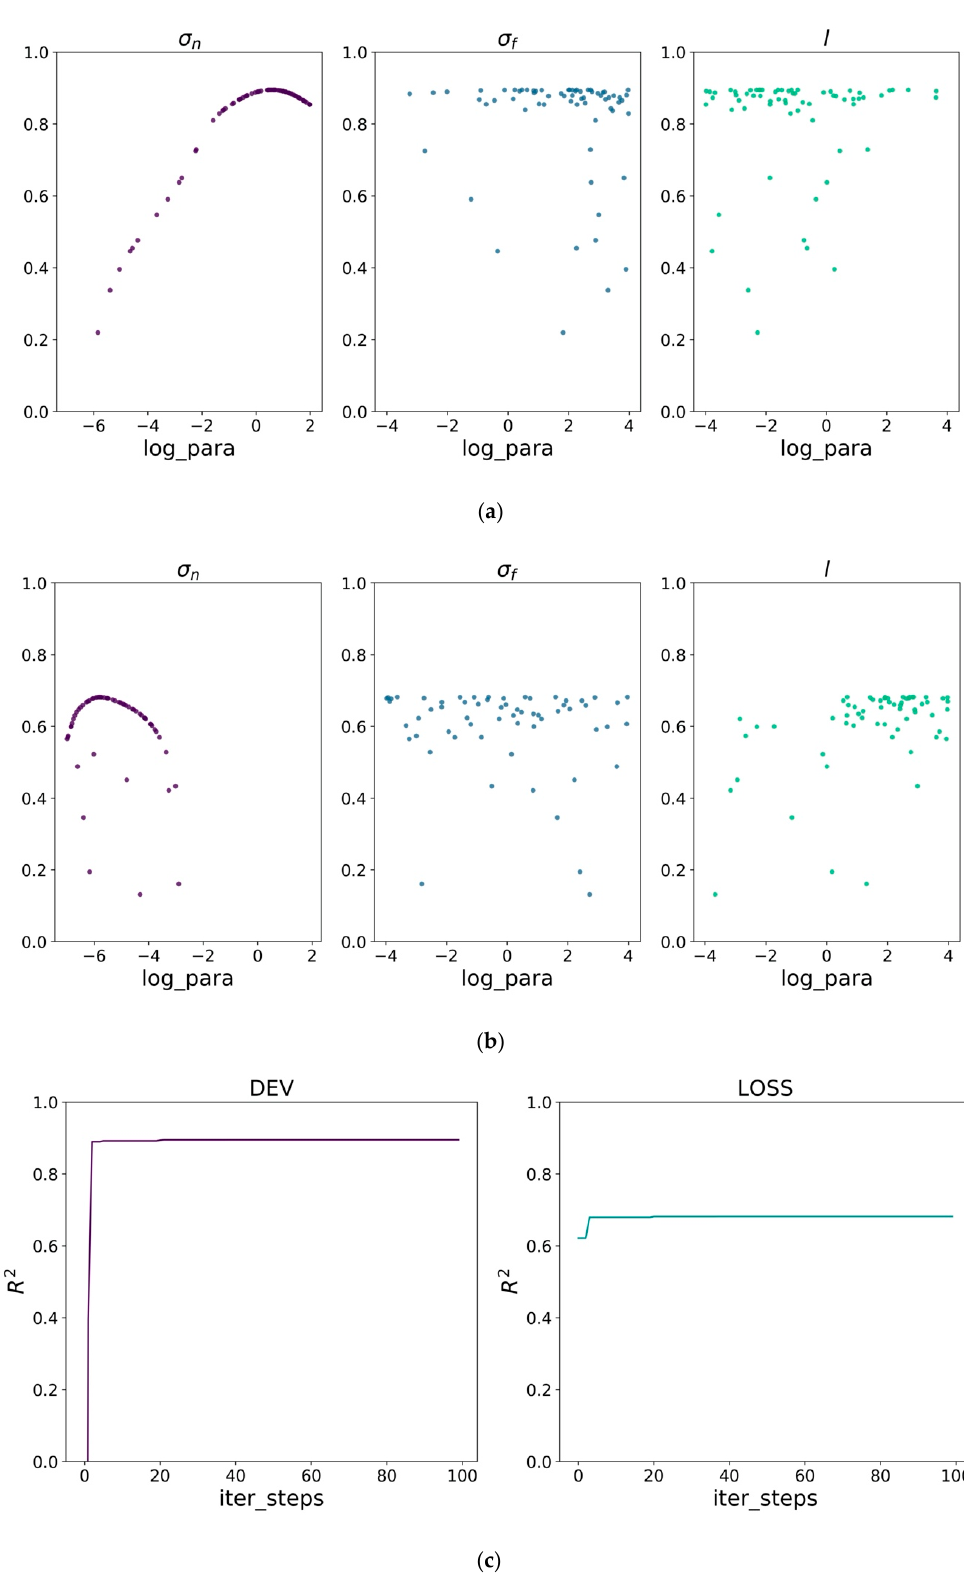
Figure 9. Optimization of training GPR models: ( a ) Hyper parameters search of deviation angle model; ( b ) Hyper parameters search of total pressure loss; ( c ) Optimization curve of models.